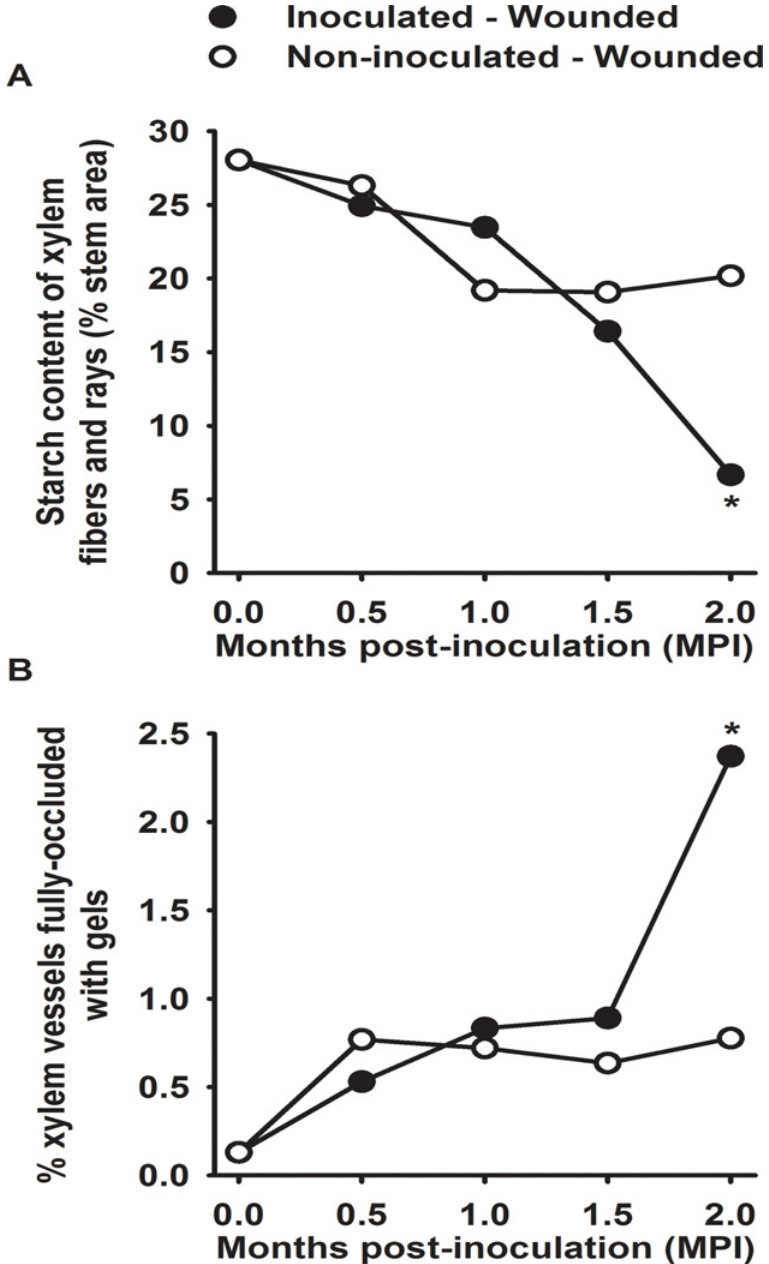
Fig 2. Plant responses to infection were significant at 2 MPI. (A) Starch content of the xylem fibers and rays decreased significantly in IW plants. Each point is the mean of three plants from stem sections at 0 cm. (B) Percentage of xylem vessels fully-occluded by gels increased significantly in IW plants. Each point is the mean of three plants, averaged across all three locations. The asterisk represents significant differences between IW and NIW plants; there were no significant differences in incubation periods without an asterisk ( P (cid:1) 0.05, Tukey ’ s test; Table 2). NINW plants represent the 0 MPI incubation period ( n = 3).